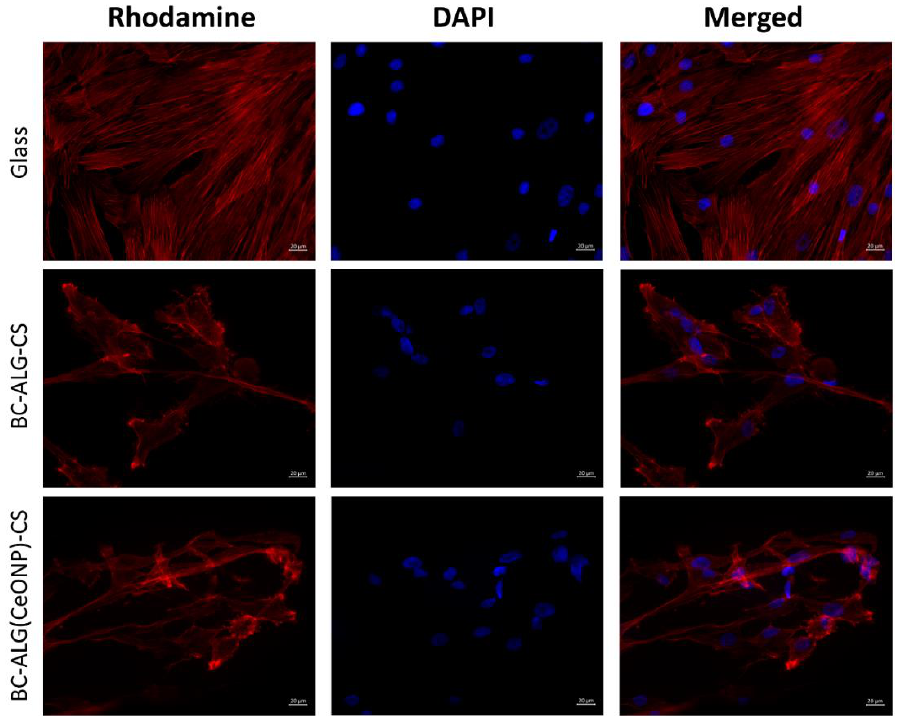
Figure 9. Multipotent mesenchymal stem cells adhered to the surfaces of glass and scaffolds. Fi- brillar actin of the cytoskeleton was stained with rhodamine fluorochrome; nuclei were stained with DAPI. Combined two-channel image, magnification ×100.